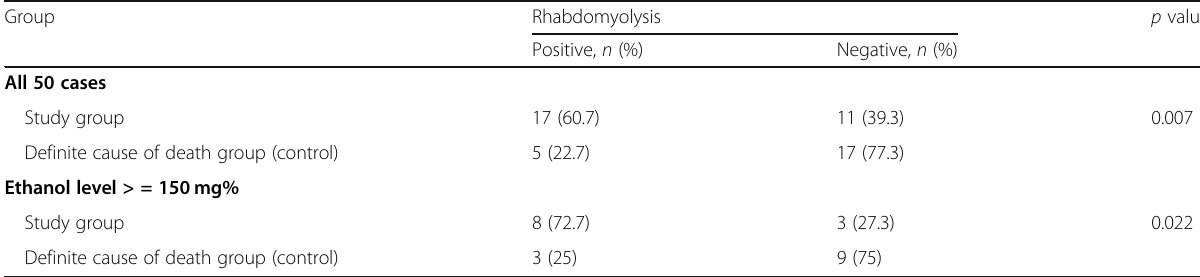
Table 6 Prevalence and comparison of rhabdomyolysis between the two groups Group